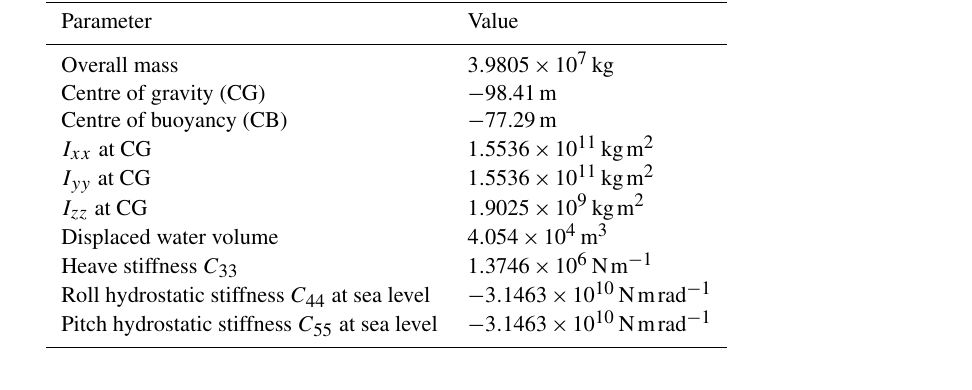
Table 4. WindCrete mooring system’s fairlead and anchor posi- tions.